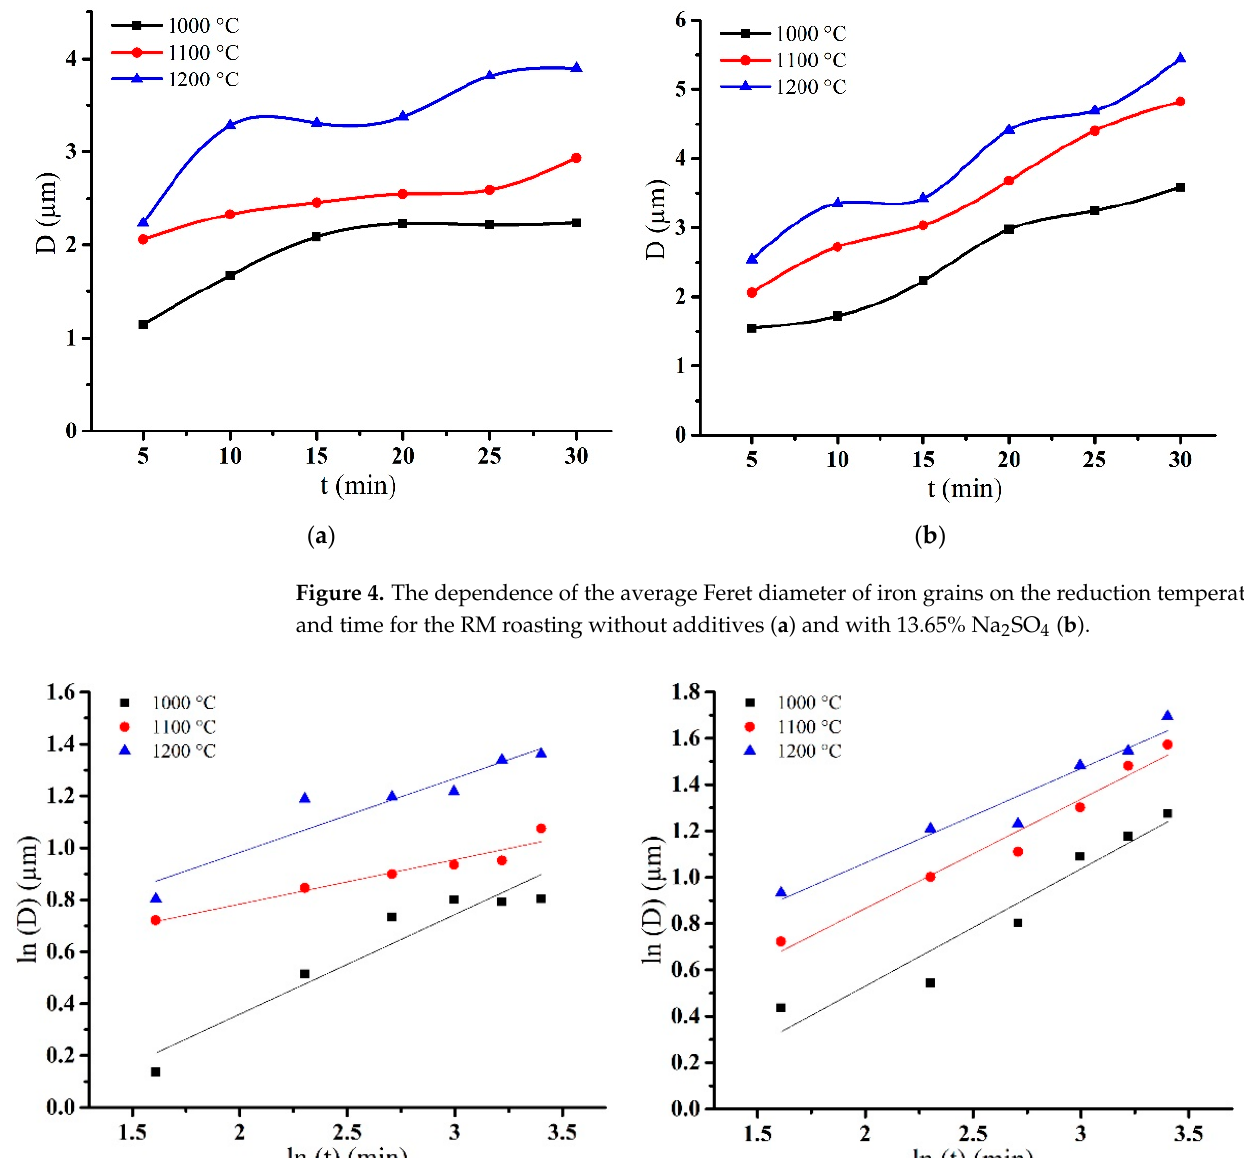
( b ) Figure 6. Influence of temperature and reduction time on grain sizes of reduced iron in the D 1/n − t plots for the RM roasting without additives ( a ) and with 13.65% Na 2 SO 4 ( b ). The values of Q G and K 0 can be obtained from the slopes and intercepts of LnK − 1/T plots, respectively. After that, the equations can be obtained for the calculation of the av- erage diameter of iron grains formed during the carbothermic reduction of RM. Figure 7 shows LnK − 1/T plots for both the carbothermic roasting RM without additives and with Na 2 SO 4 .